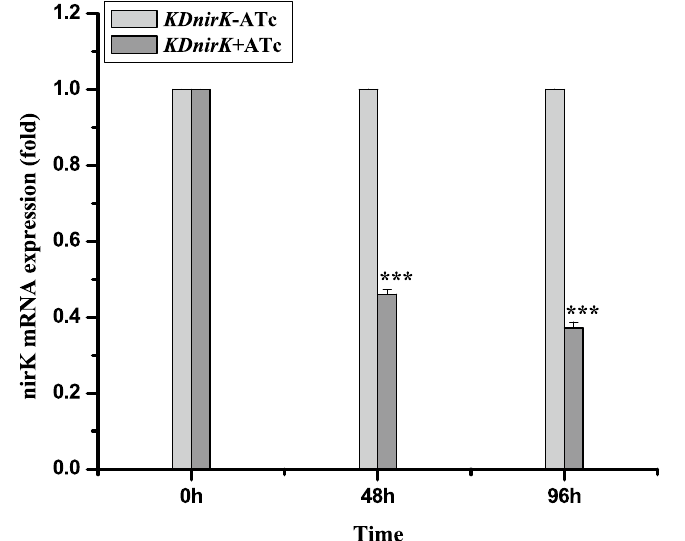
Figure 6. Level of mRNA of MRA2164 gene expressed in ATc induces KDnirK Mycobacterium tuberculosis : Relative quantification was done by using SYBR green based qPCR kit and fold change were calculated for mRNA obtained from ATc induced KDnirK Mtb cells of 0 h, 48 h and 96 h (gray color). SigA gene was used as a housekeeping reference. The light gray color represents the fold change obtained from uninduced KDnirK Mtb cells as control. The data represented as the mean of three experiments ±